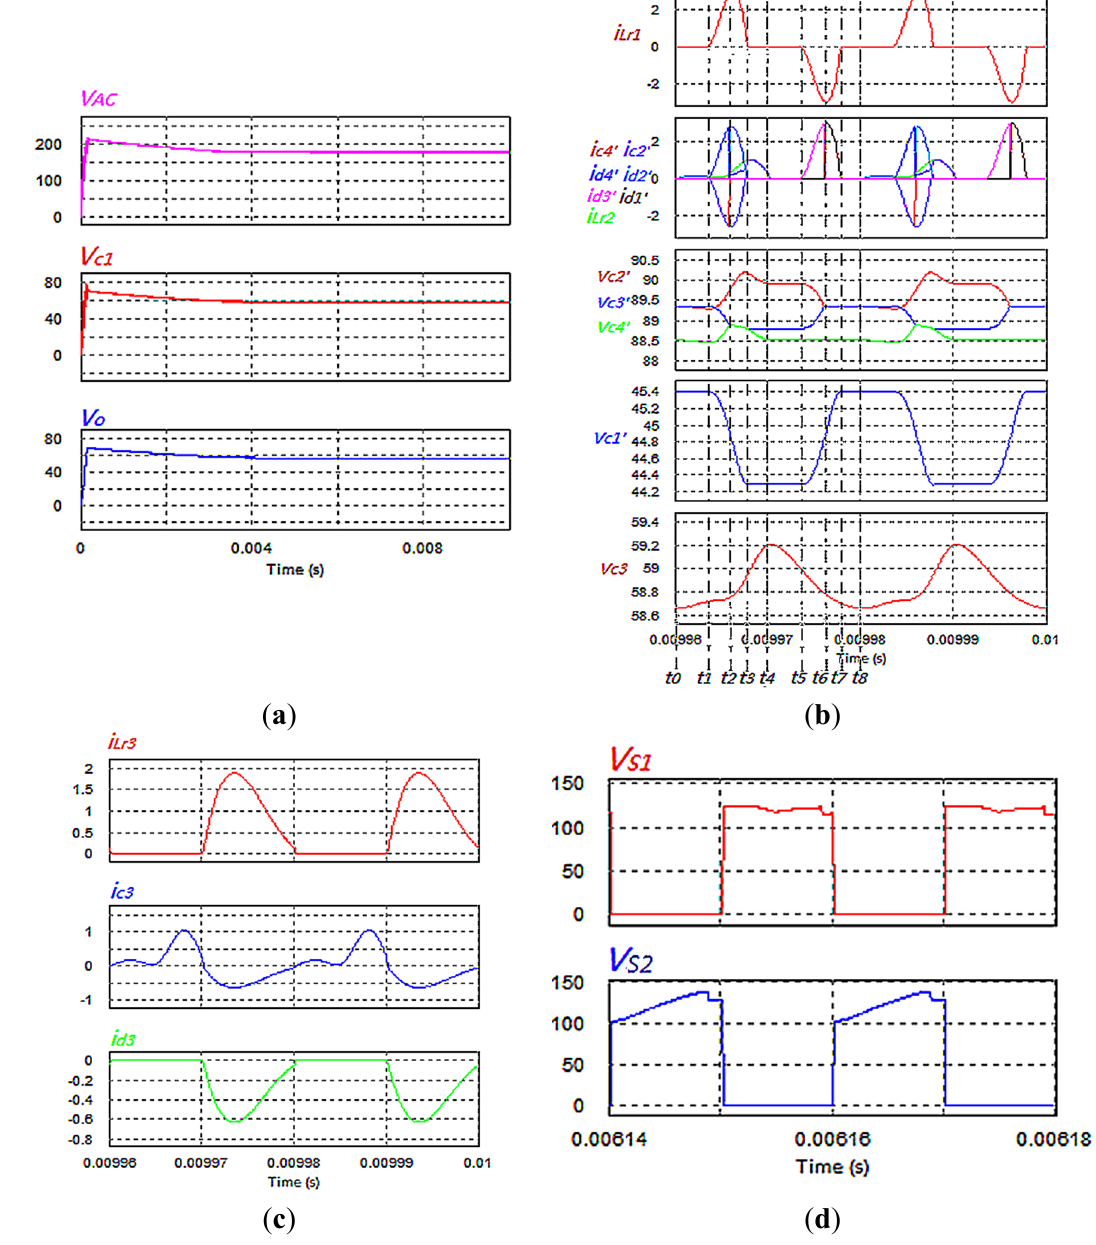
Figure 7. Waveform of the current and voltage of the proposed circuit: ( a ) V AC , V c1 and V o ; ( b ) resonant inductor and switched-capacitor voltages and currents; ( c ) i Lr3 , i c3 , i d3 ; and ( d ) switch